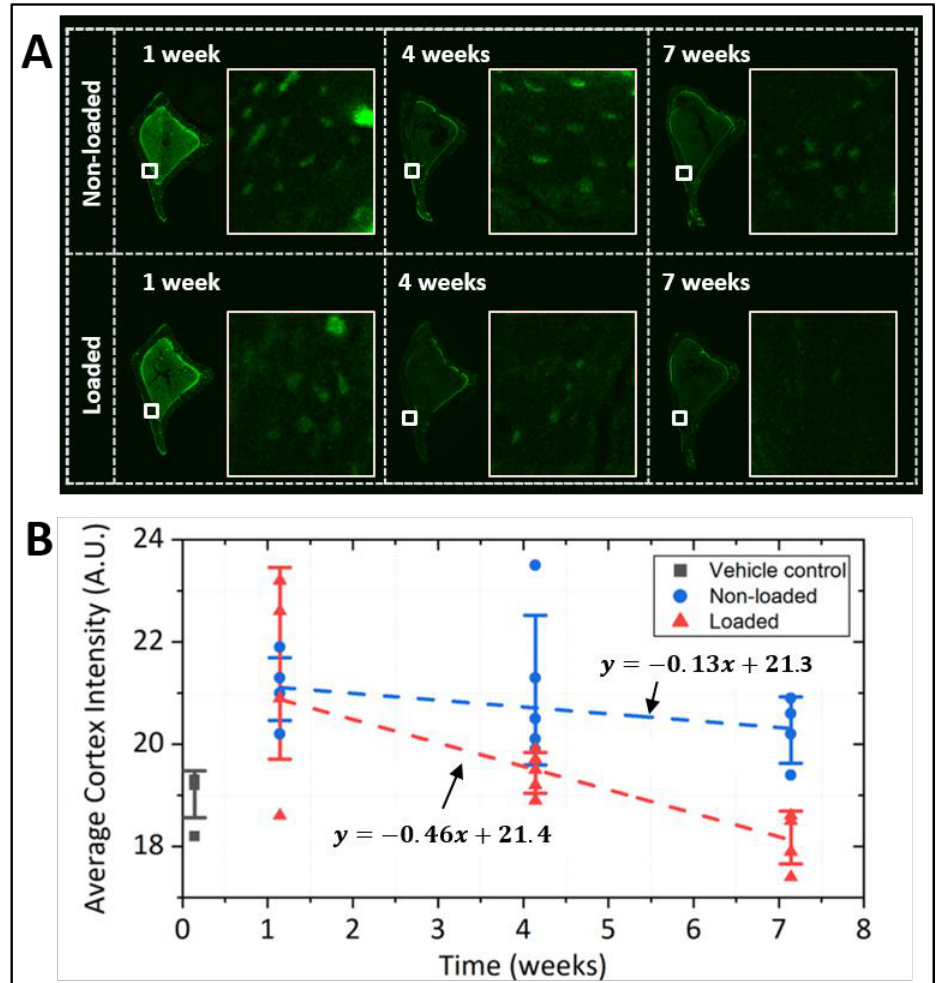
Figure 6. Pulse-chase experiment on metabolically labeled osteocytic PCM in mechanically loaded mice. ( A ) Representative images of tibial cross sections (left) and magnified regions of the anterior- medial portion of the cortex (white boxes, right) from non-loaded and loaded bones at various time points. ( B ) PCM labeling intensity (averaged over the entire cross-section, four sections per time point) showed a linear decrease with time, and the slope was ~3.5 times steeper in the loaded bones than non-loaded bones ( p = 0.01). The PCM labeling intensities, after subtraction of background (the mean value from the vehicle control group), yielded half-lives of 62 d and 18 d for non-loaded and loaded bones, respectively.